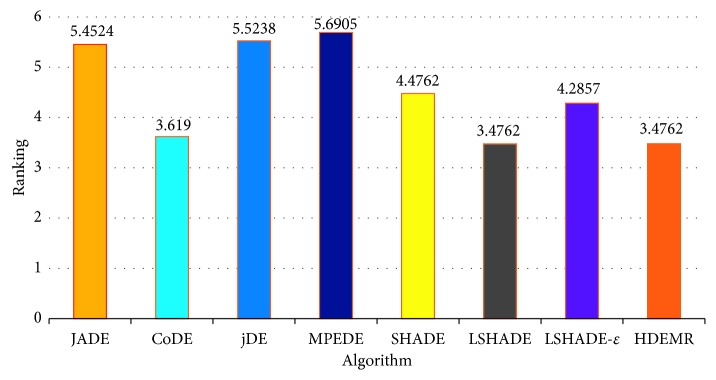
Average rankings of the eight algorithms by Friedman test for CEC2005 at D=10.